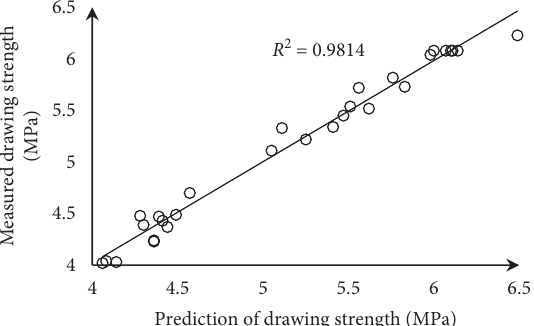
Figure 14: The drawing strength of the test results and the prediction results.